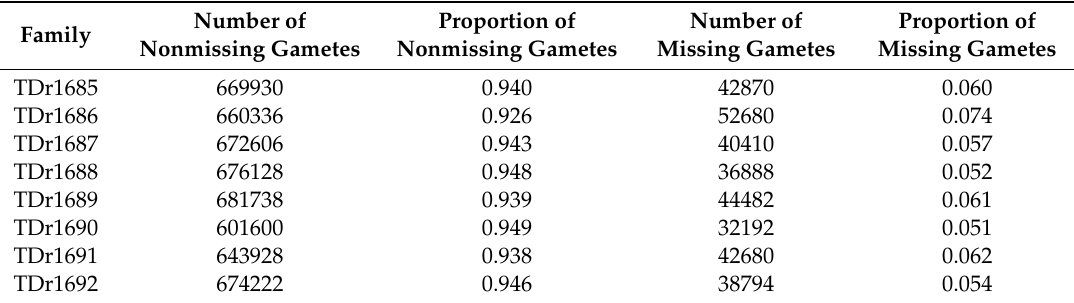
Table 3. Gamete frequency of eight polycross-derived families of yam.